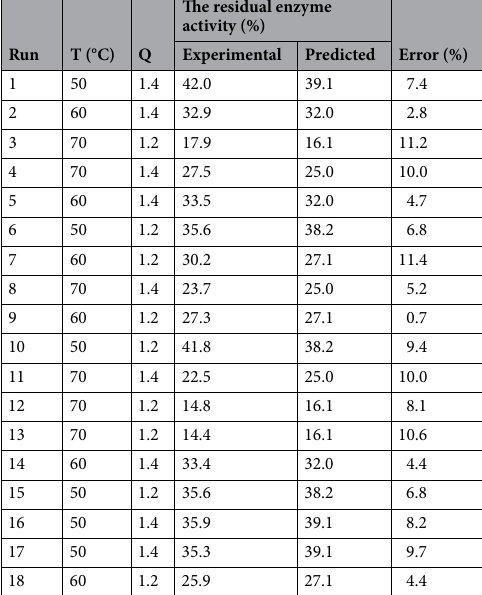
Table 1. The results of full factorial design relevant to the residual enzyme